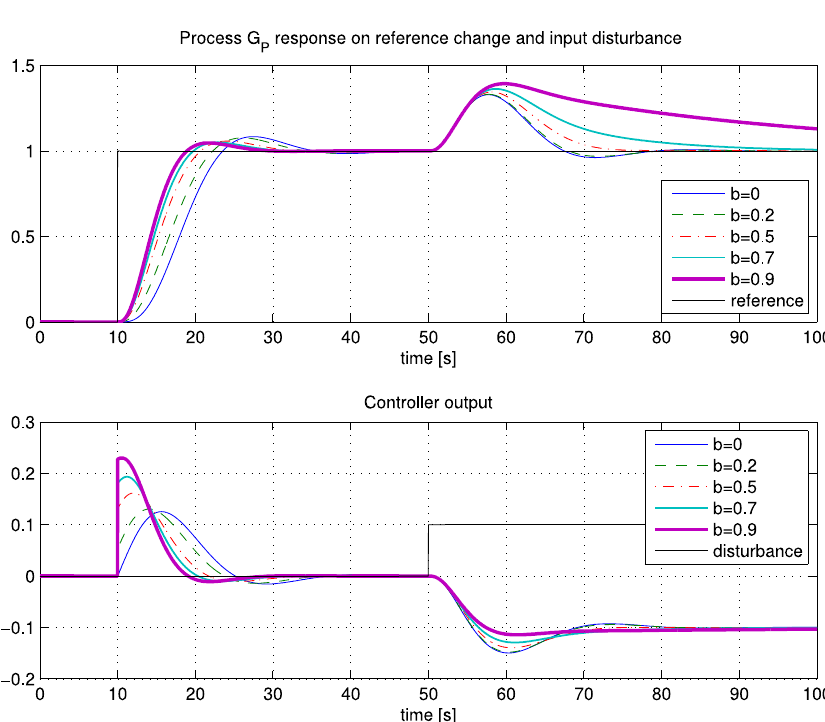
ff erent values of b